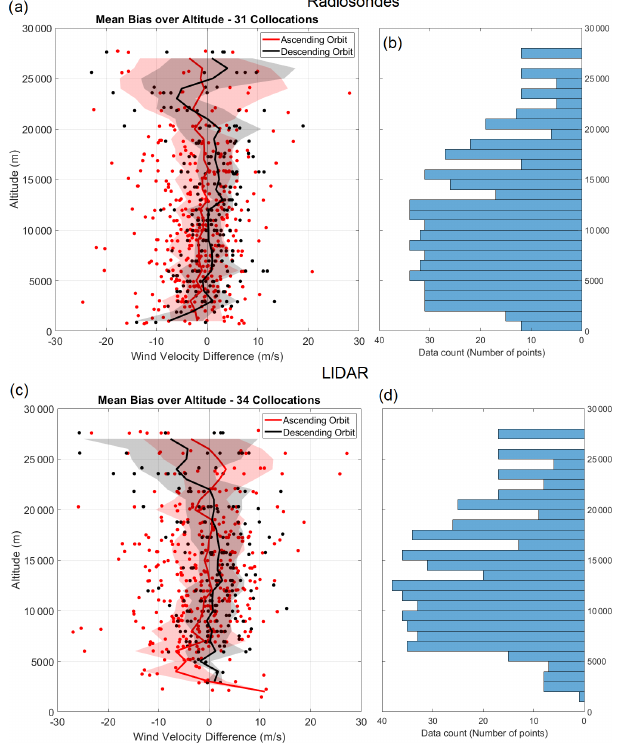
Figure 3. (a) The Aeolus minus the radiosonde HLOS wind dif- ference made during all AboVE campaigns over each altitude bin. (b) The number of data samples over each altitude bin for the ra- diosonde comparison. (c) The Aeolus minus the lidar HLOS wind difference made during all the campaigns over each altitude bin. (d) The number of data samples over each altitude bin for the lidar comparison. Red represents measurements of an ascending orbit, while black represents measurements of a descending orbit. The lines represent the average bias of each bin altitude, and the red (black) shading is the standard deviation of the bias in each range bin for ascending (descending)